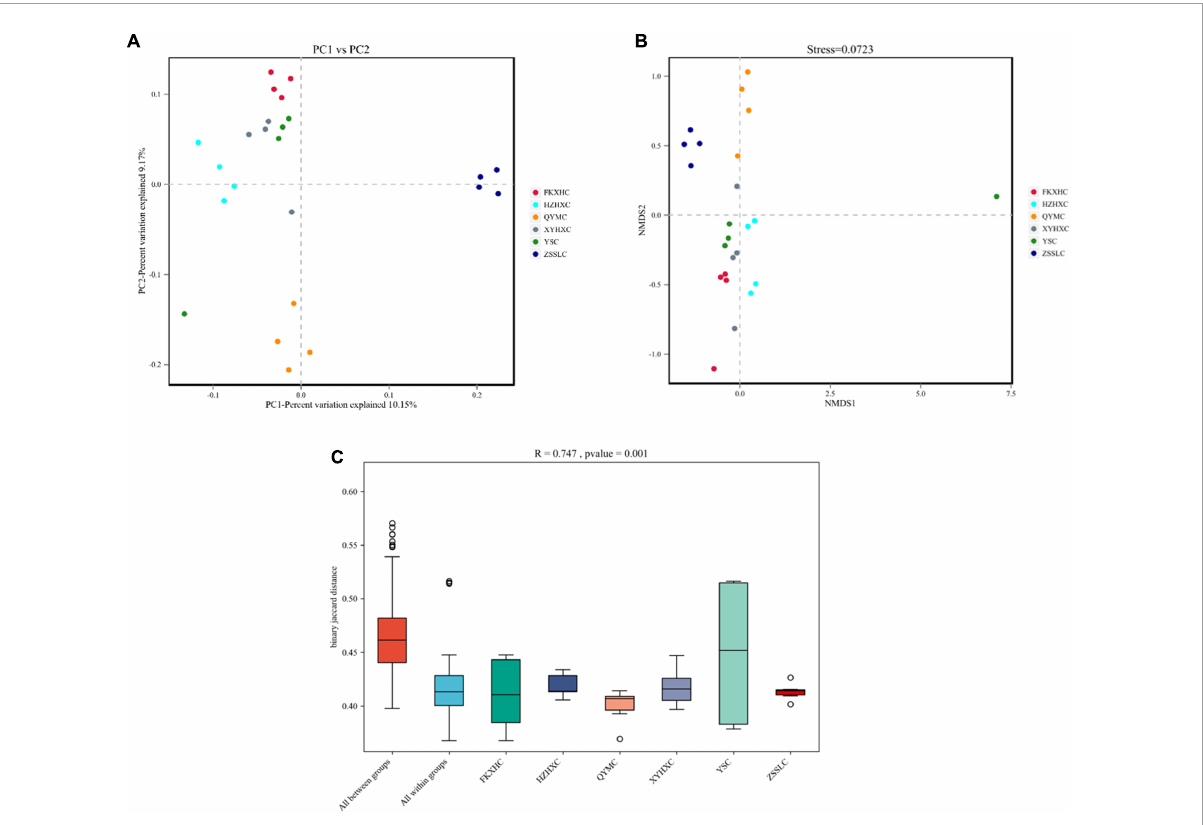
FIGURE3 Beta-diversity analysis. (A) PCoA plot and (B) NMDS plot of binary-jaccard distances among six groups. (C) ANOSIM plots for variations among six groups.